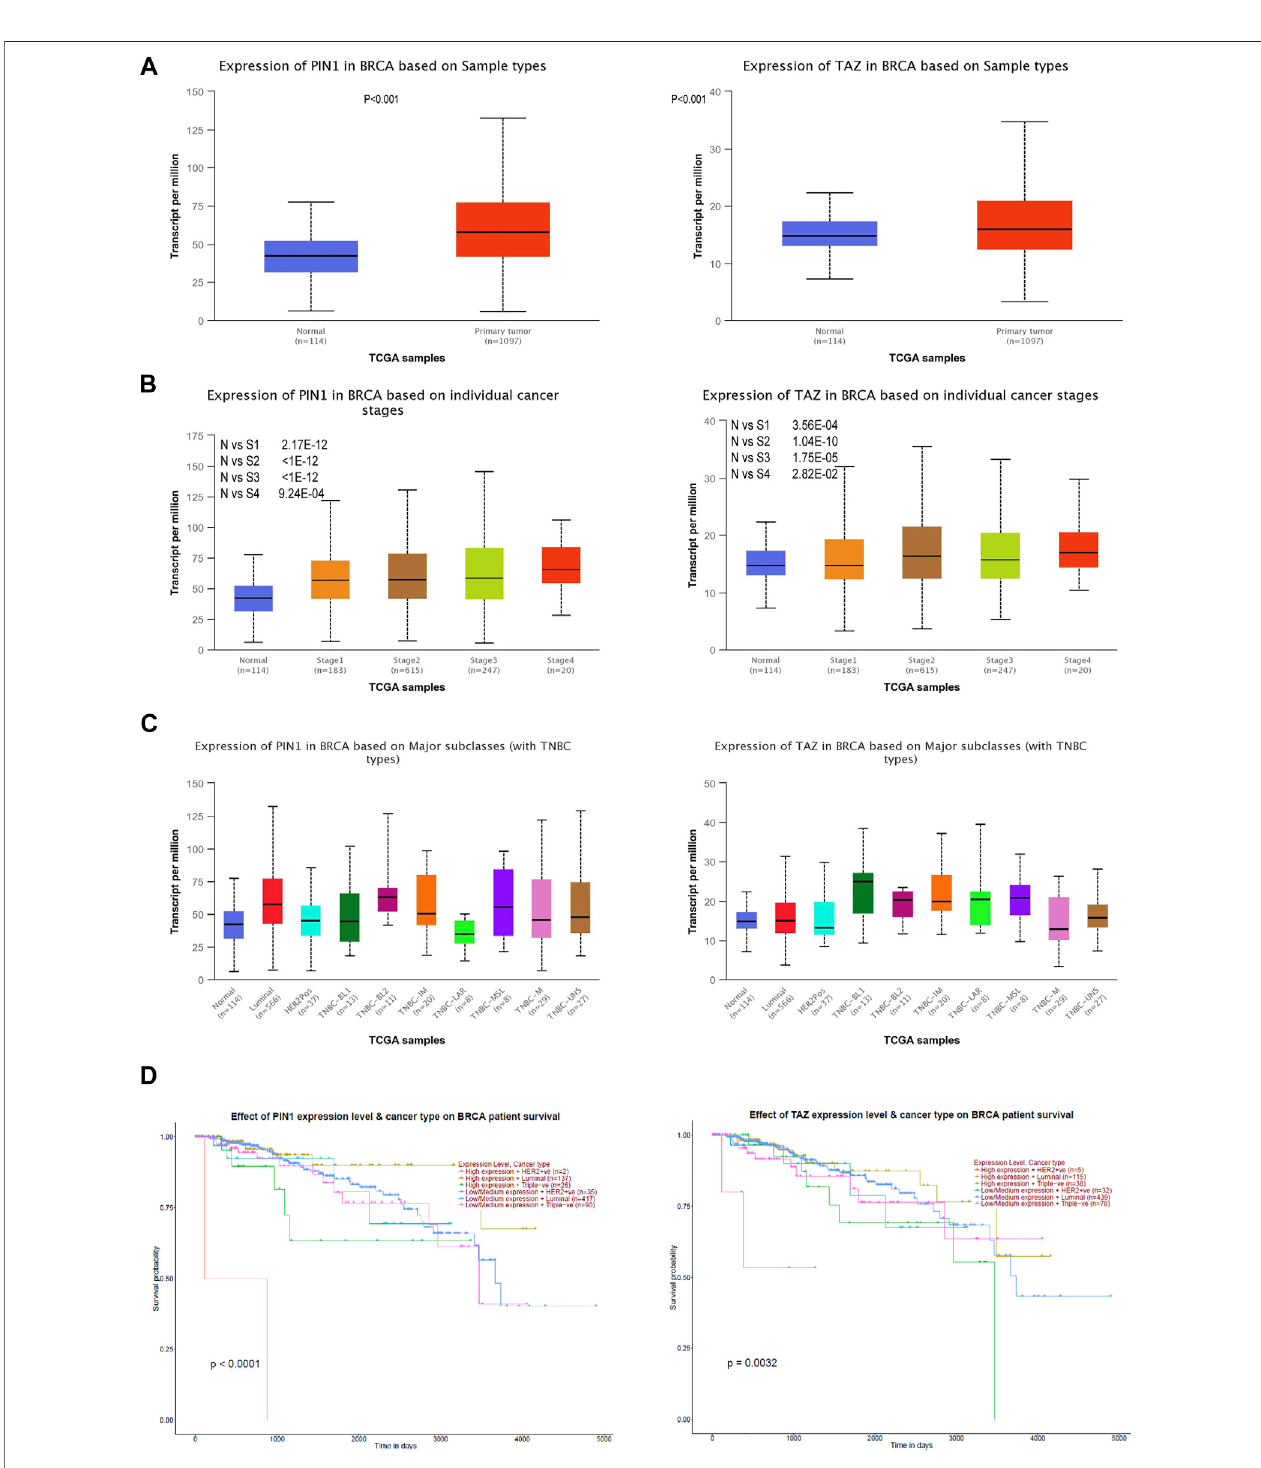
FIGURE 7 | Pin1 and TAZ are highly expressed in TNBC. (A) Pin1 and TAZ are highly expressed in breast cancer. (B) Pin1 and TAZ are highly expressed in high- stagebreastcancer. (C) Pin1(N-vs-Luminal:1.6×10 − 12 ,N-vs-HER2Pos:0.18,N-vs-TNBC-BL1:0.32,N-vs-TNBC-BL2:0.0093,N-vs-TNBC-IM:0.0079,N-vs-TNBC- LAR: 0.85, N-vs-TNBC-MSL: 0.18, N-vs-TNBC-M:0.024, and N-vs-TNBC-UNS: 0.013.) and TAZ (N-vs -Luminal: 0.00012, N-vs-Her2Pos: 0.57, N-vs-TNBC-BL1: 0.007, N-vs-TNBC-BL2: 0.08, N-vs-TNBC-IM: 0.00068, N-vs-TNBC-LAR: 0.13, N-vs-TNBC-MSL: 0.08, N-vs-TNBC-M: 0.49, and N-vs-TNBC-UNS: 0.093) are highly expressed in TNBC. (D) Relationship between Pin1 and TAZ expression and patient survival in TNBC patients.